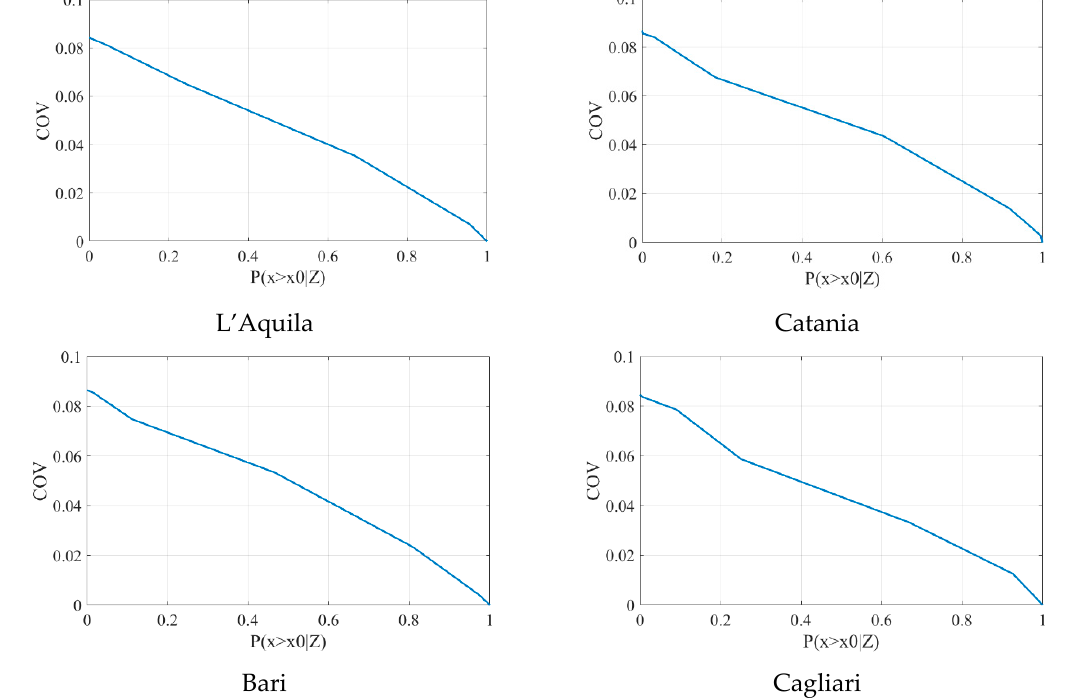
Figure 13. Maximum drift COV variation for severe damage condition in case of 500 kg bomb for each structure location.